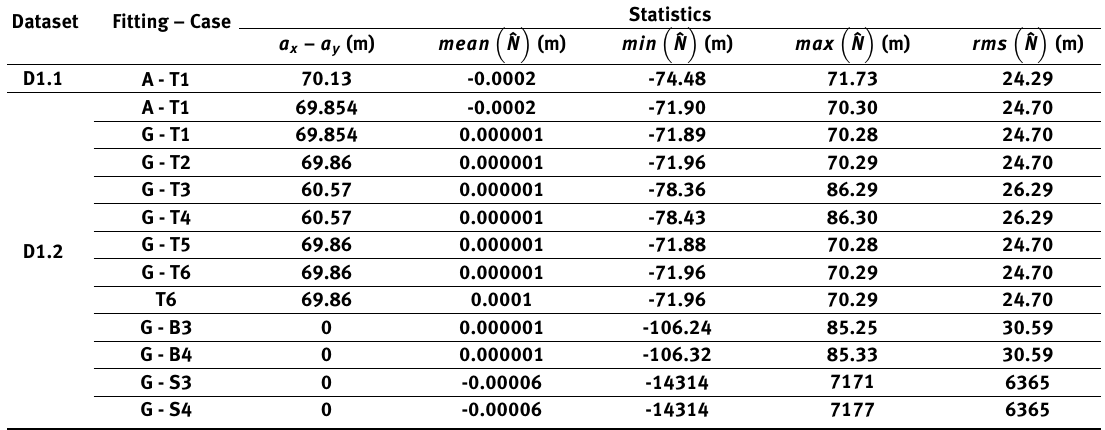
Table 6. Statistics of fitting for the geoid model